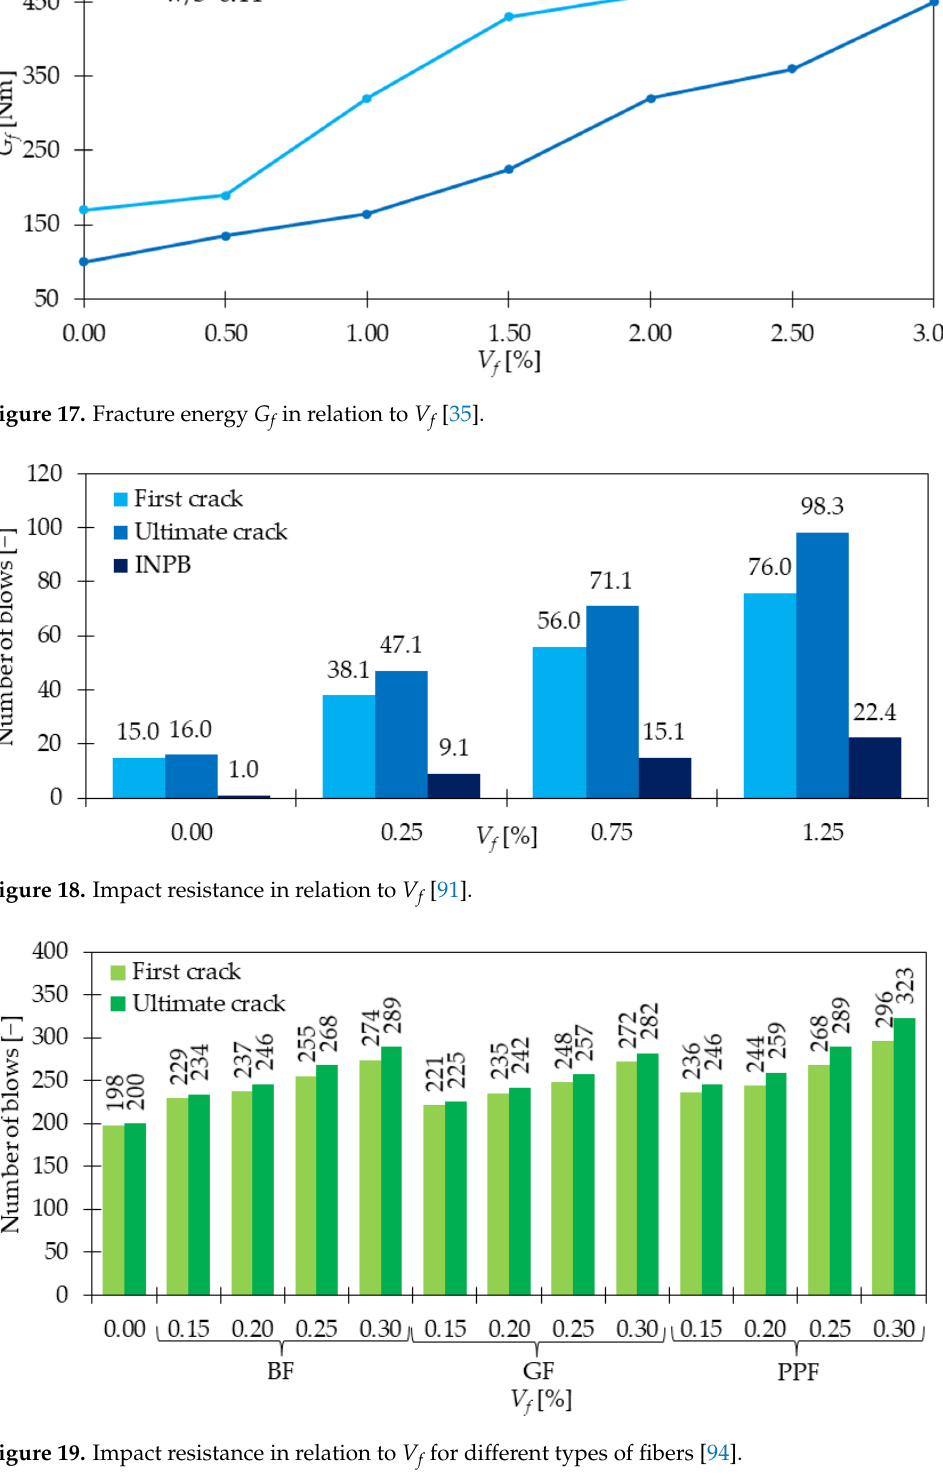
Figure 19. Impact resistance in relation to V f for different types of fibers